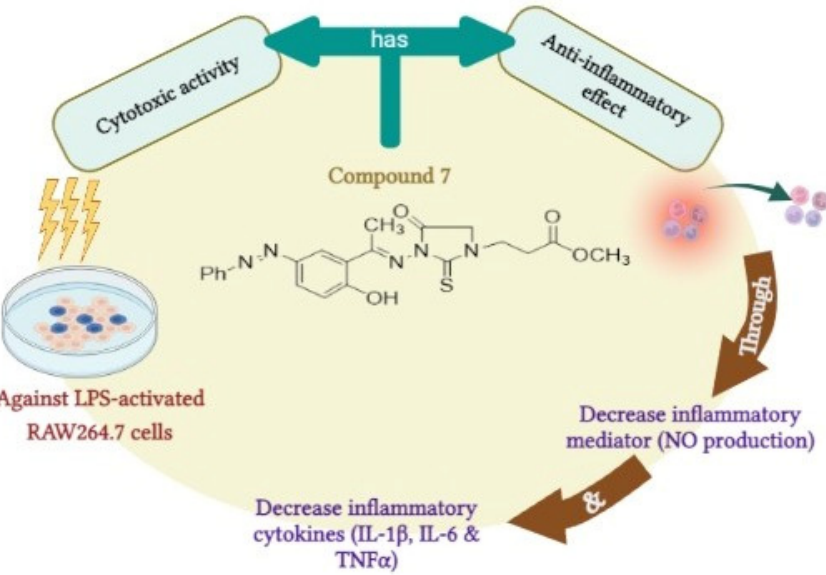
Figure 8. The predicted mode of action for the anti-inflammatory activity of compound 7